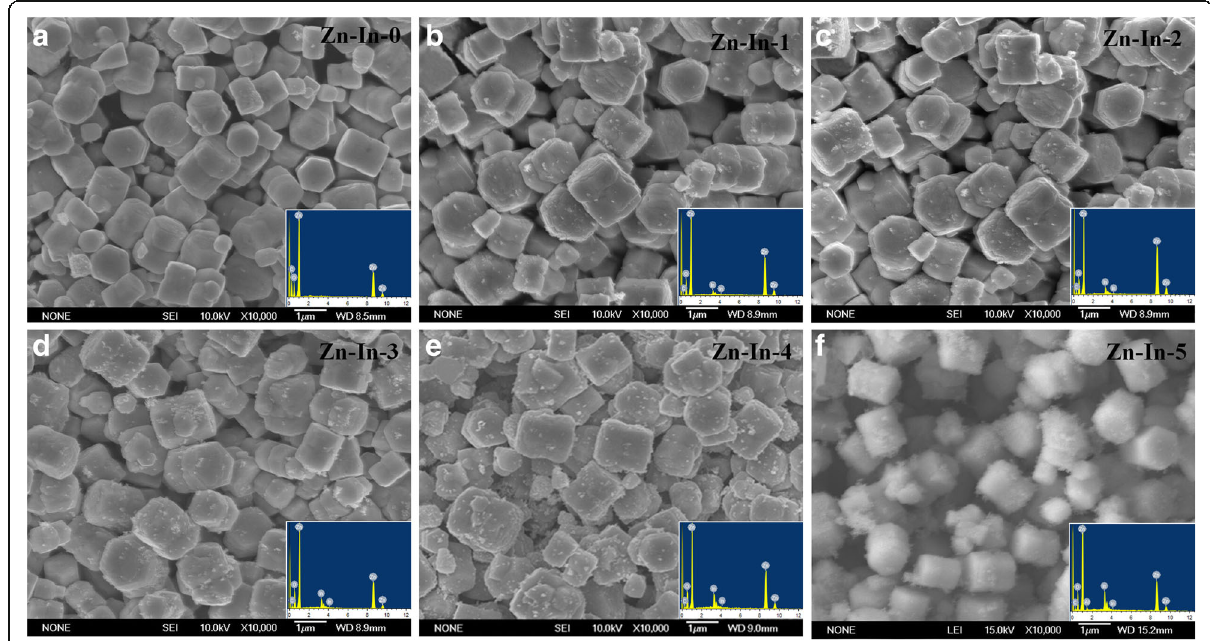
Fig. 1 SEM images of ZnO/In 2 O 3 composites with different In 2 O 3 amount ( a – f ). The insets are the EDS spectra corresponding samples